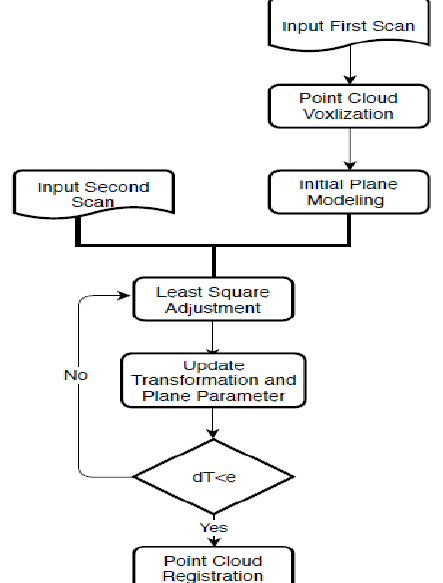
Figure 1. Flowchart of the proposed method